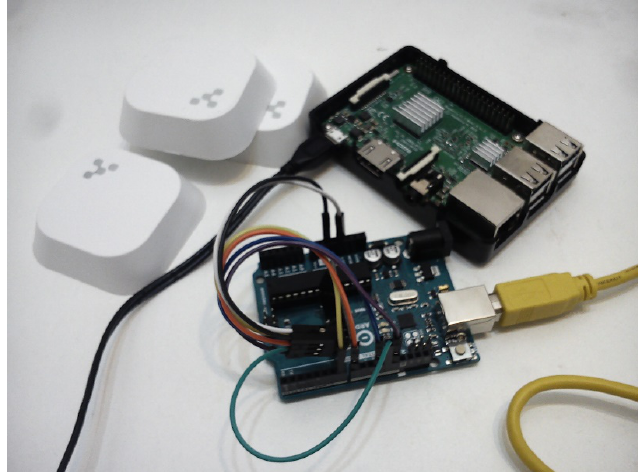
Figure 4. Testing equipment